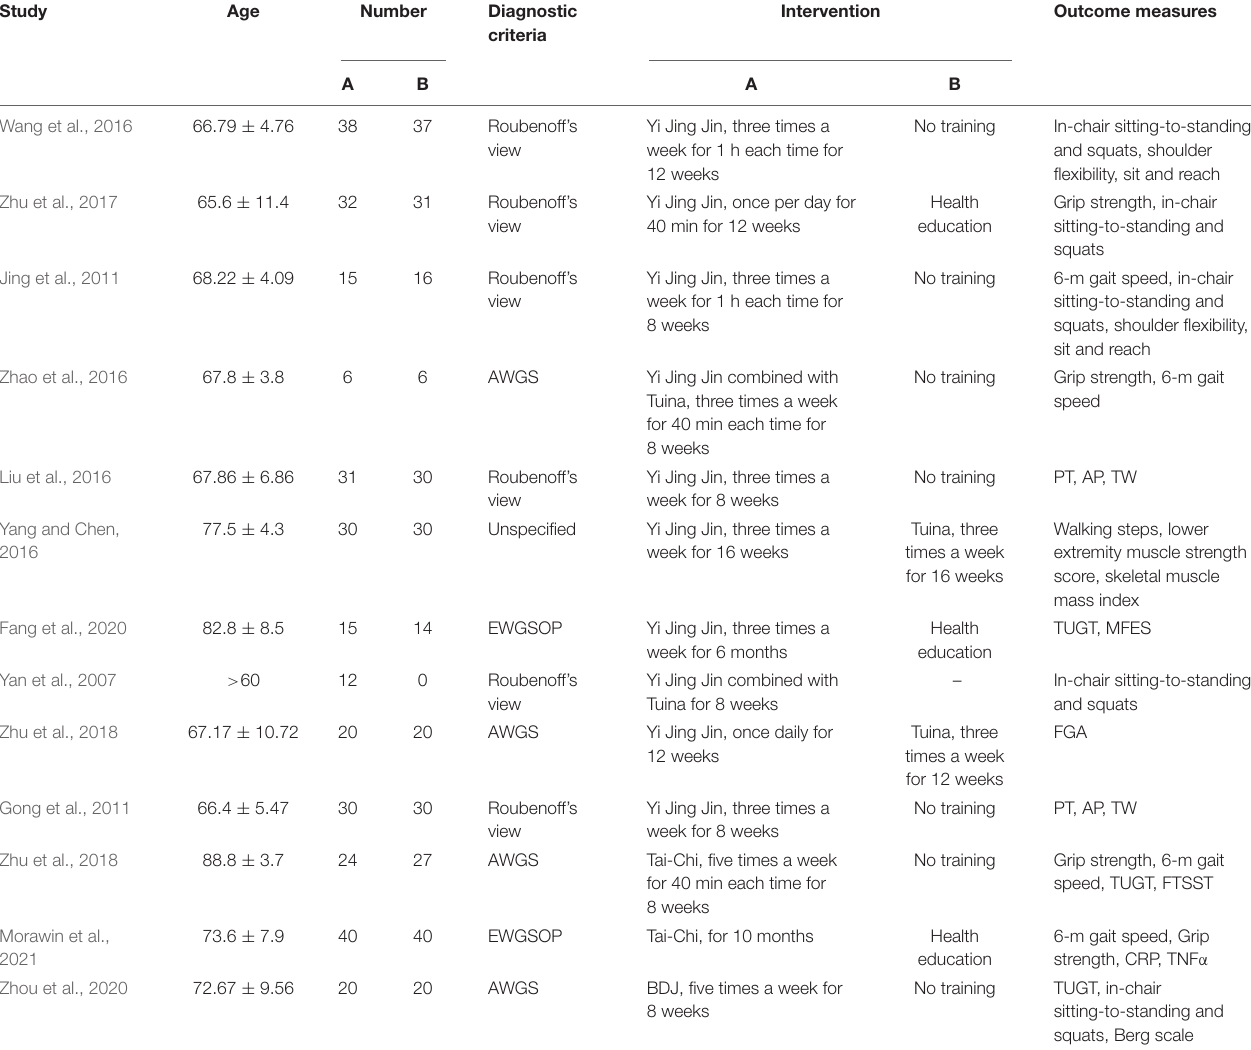
TABLE 1 | Characteristics of the included studies of Traditional Chinese Qigong